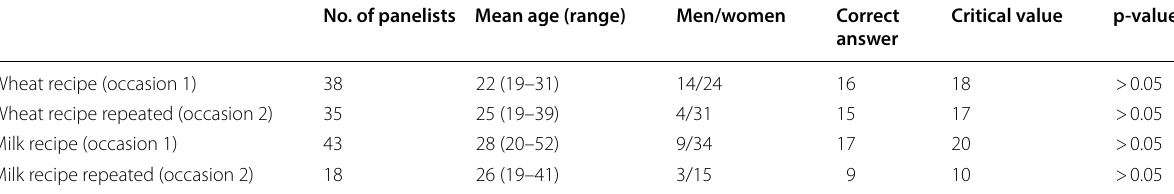
Table 2 Evaluation of triangle test for identification of active food sample No. of panelists Mean age